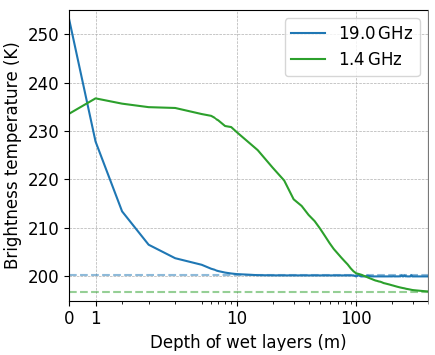
Figure 8. DMRT-ML brightness temperature at H polarization (K) for 55 ◦ of incidence angle as a function of the wet-snow-layer depth within the snowpack for a wet-layer thickness of 1m at 1.4GHz (green) and 0.1m at 19GHz (blue). Values for a dry snowpack are in dashed